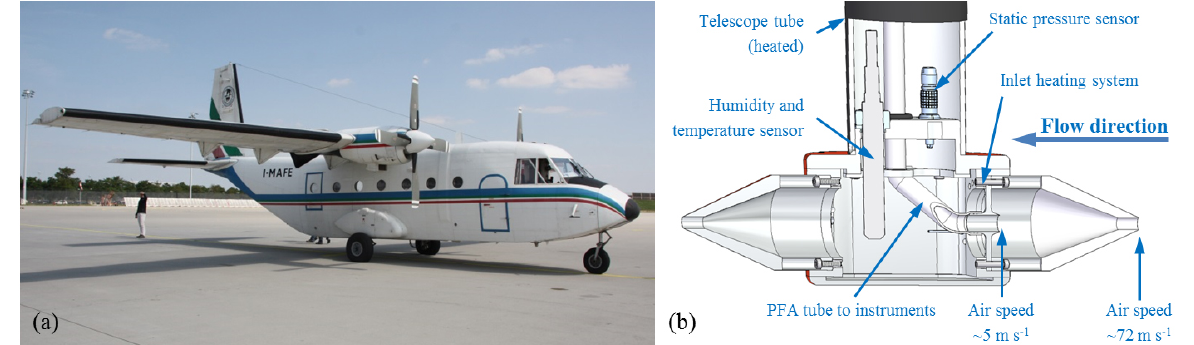
Figure 2. For the ETMEP-2 campaign in August 2013 the CASA 212 (a) from the Italian company Compagnia Generale Ripreseaeree (http://www.terraitaly.it/) was equipped with a specially designed and manufactured PTFE-coated trace gas inlet (b) .